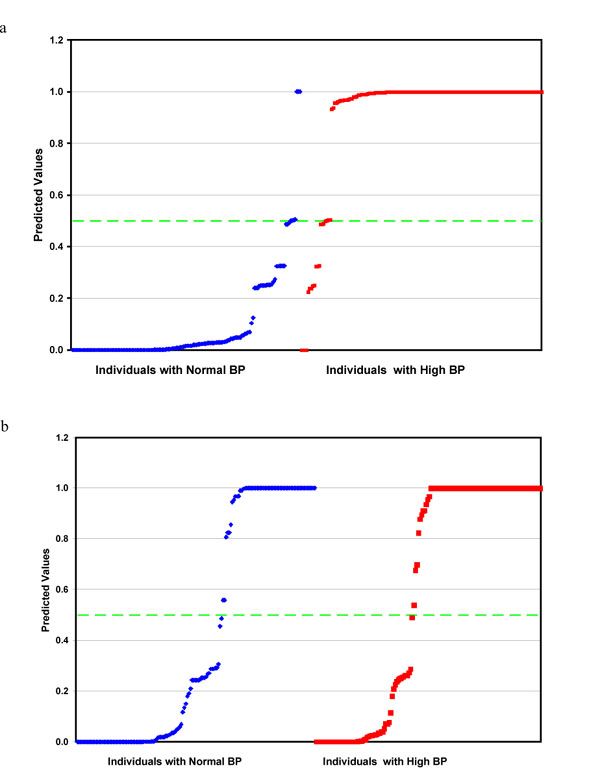
Neural network results: Strategy 1 Cohort 2 a, Results for the training set; b, Results for the validation set. Model with five hidden units. (Blue diamond) Normal BP.,(Red square) High BP; Y < 0.5, normal BP predicted by neural network; Y ≥ 0.5, high BP predicted by neural network.